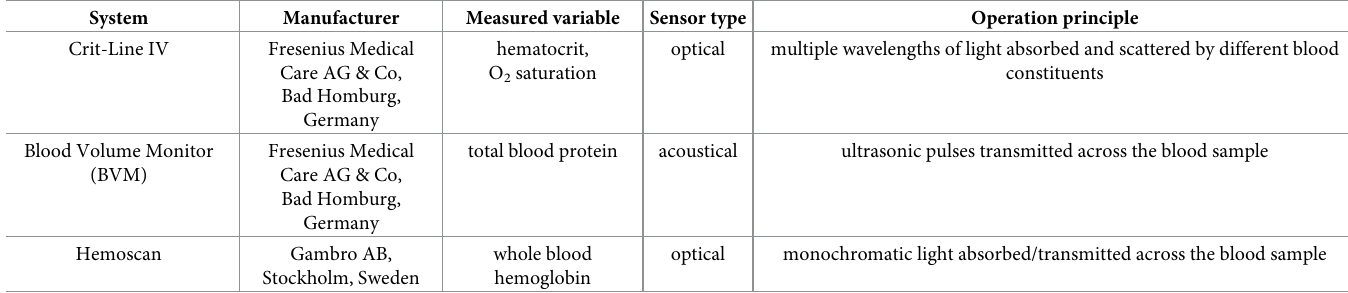
Table 1. Examples of commercially available systems for monitoring relative blood volume changes during